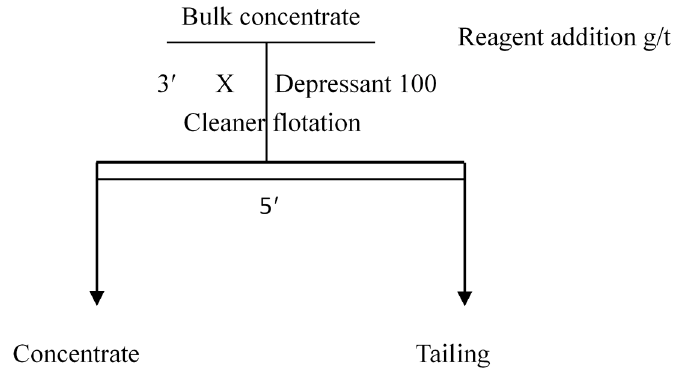
Figure 1. The beneficiation flowsheet of bench scale tests.